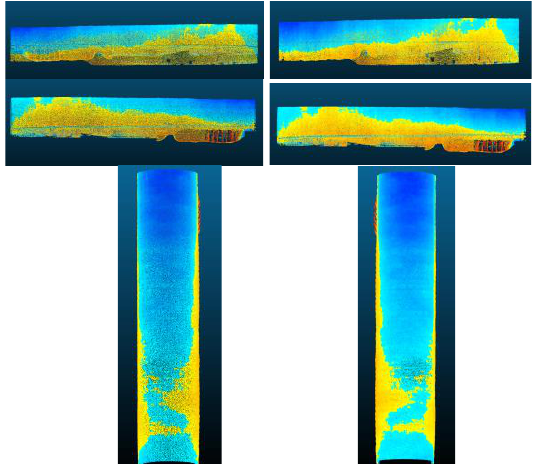
Figure 17 . Tunnel point cloud over-undercut visualization (left input is a raster voxel sampled at 0.06f, right is